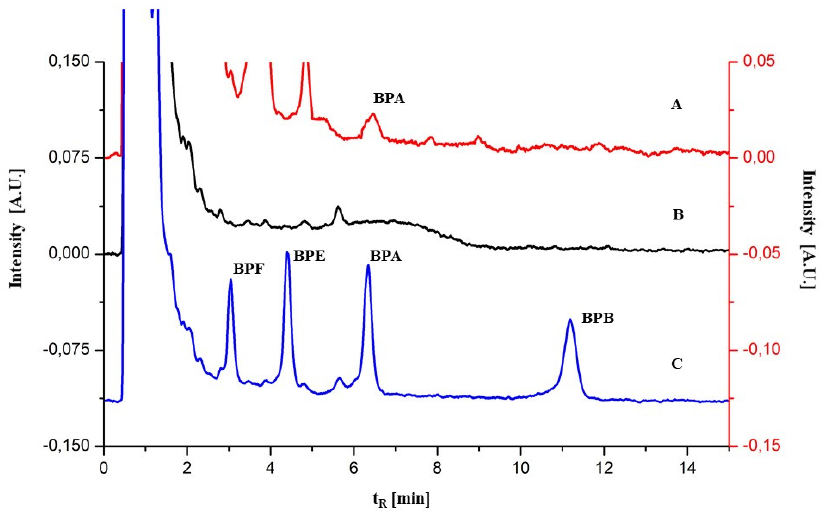
Figure 4. LC-FLD chromatograms of (A) liquid pineapple sample after microgel preconcentration (with the visible peak for BPA, t R = 6.39 min), (B) liquid pineapple sample before preconcentration procedure and (C) liquid pineapple spiked with the standard solution of bisphenols (0.5 mg·L − 1 ). Table 2. The detected concentration of bisphenol A in liquid food samples after the extraction pro- cedure.